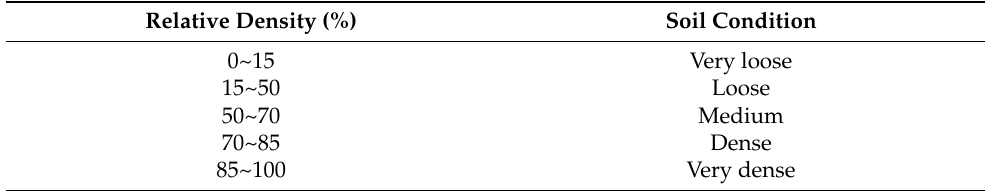
Table 4. Relationship between relative density and soil condition of the sand [20].